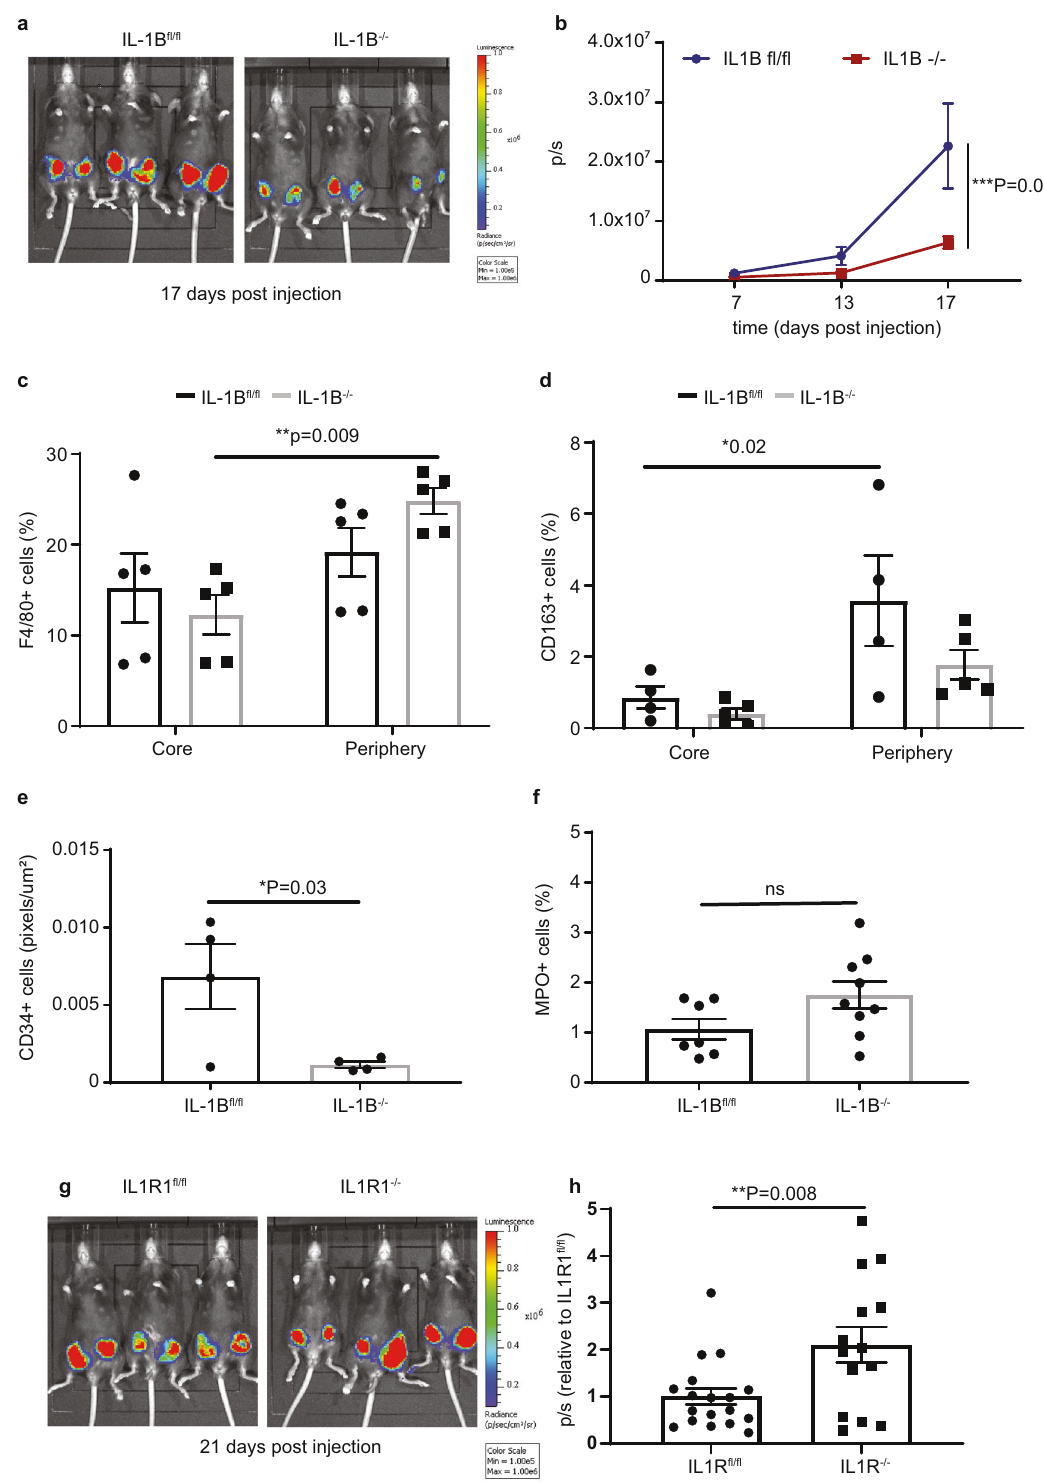
Fig. 3 Tumour-derived IL-1B restores the in fi ltration of innate immune cells that may display anti-tumour functions and inhibits primary tumour growth in an IL-1B de fi cient microenvironment. a , b Images and quanti fi cation of primary tumour development in IL-1B fl / fl ( n = 8 primary tumours from n = 4 mice) and IL-1B − / − ( n = 10 primary tumours from n = 5 mice) mice after intra-ductal administration of E0771 Luc2 V5 IL-1B-GFP cells. Data are mean + / − SEM, Two-way ANOVA with Sidak ’ s post-hoc test. c , d Quanti fi cation of F4/80 + macrophages ( c ) and CD163 + macrophages ( d ) in tumour core and periphery in IL-1B fl / fl and IL-1B − / − mice. Data are mean ± SEM, Two-way ANOVA with Sidak ’ s post hoc test. e , f Quanti fi cation of CD34 + blood vessels and MPO + neutrophils in IL-1B fl / fl and IL-1B − / − mice. Data are shown as mean + / − SEM, Two-tailed unpaired t -test. g , h Images and quanti fi cation of primary tumour development in IL1R1 fl / fl ( n = 18 primary tumours from n = 9 mice) and IL1R1 − / − ( n = 14 primary tumours from n = 7 mice) mice after intra-ductal administration of E0771 Luc2 V5 IL-1B-GFP. Normalised data are shown as mean + / − SEM, Two-tailed unpaired t -test. Published in partnership with the Breast Cancer Research